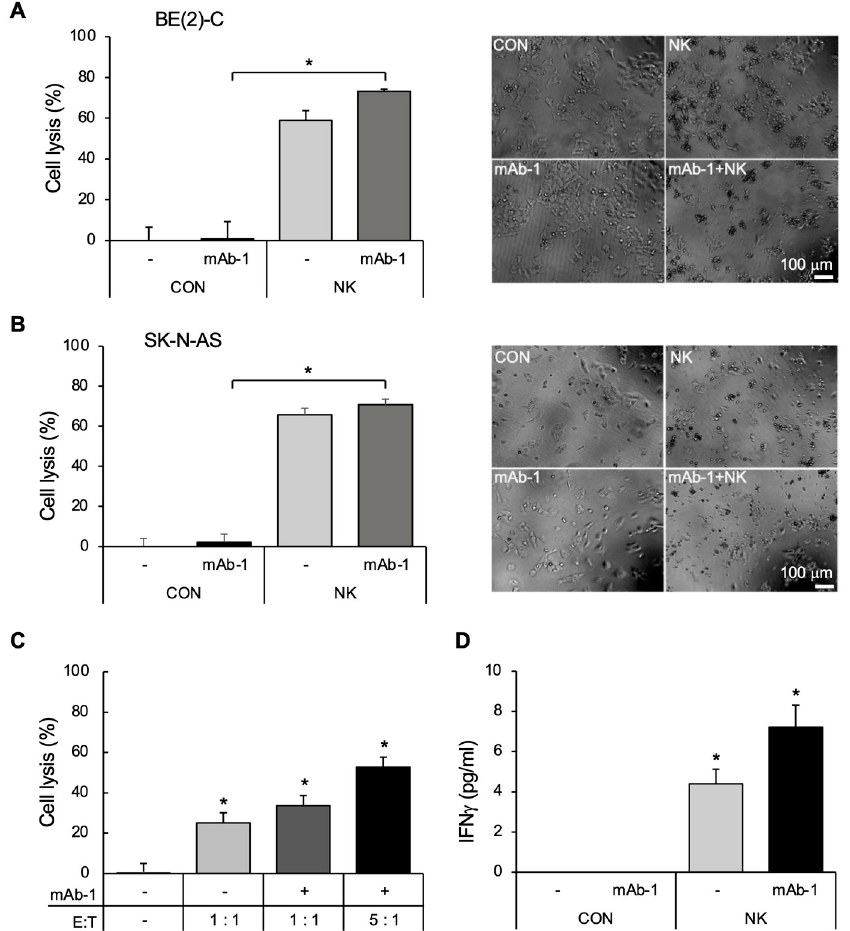
Fig 4. GRP-R mAb–mediated antibody-dependent cellular cytotoxicity (ADCC) in neuroblastoma. (A) BE(2)-C/ Luc as target cells were co-cultured with effector NK cells (E:T at 2:1) with or without GRP-R mAb-1 at 2 μ g/ml for 4 hours. The percent of lysed cells was calculated by measuring the luciferase activity of survived cells in control samples and treated samples (Left). The typical cell images were taken under microscope, showing the integral and killed cells (right). (B) ADCC assay in SK-N-AS cells. SK-N-AS/Luc as target cells were co-cultured with effector NK cells (E:T at 2:1) with or without GRP-R mAb-1 at 2 μ g/ml for 4 hours (Left). The typical cell images were taken using microscopy, showing the integral and killed cells (right). (C) ADCC assay in BE(2)-C cells. The cells were co-cultured with effector NK cells with or without GRP-R mAb-1 at 2 μ g/ml for 24 hours. (D) The secretion of IFN γ in the co-culture media was measured with ELISA kit. BE(2)-C cells were co-cultured with NK cells (E:T at 2:1) with or without GRP-R mAb-1 (2 μ g/ml) for 24 hours. Data represent mean ± STDEV; � = p < 0.05 vs. CON.